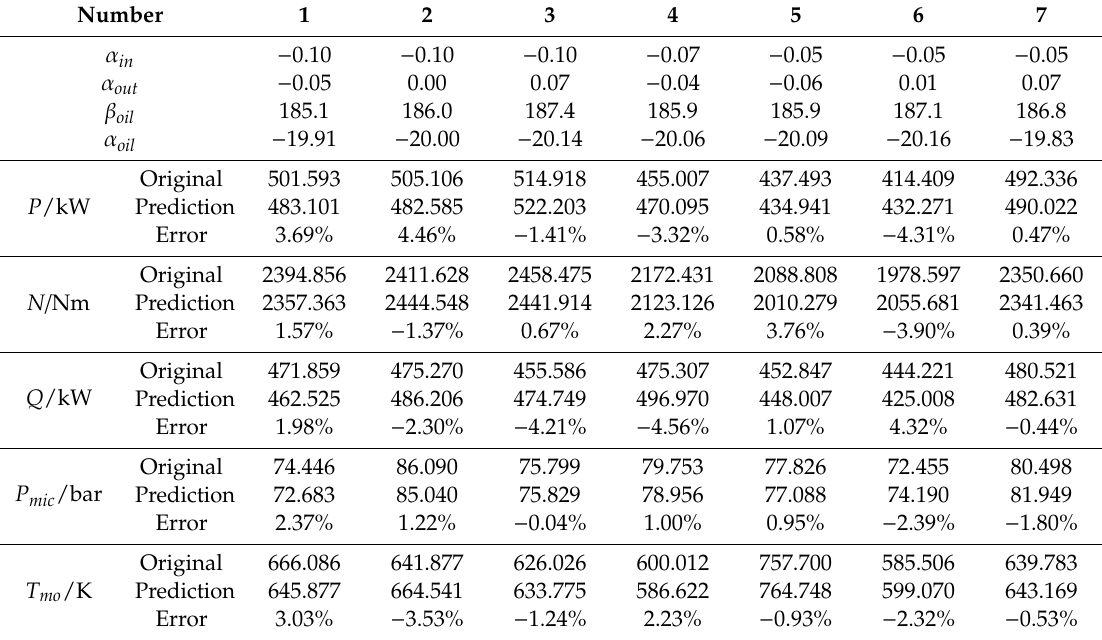
Table 8. The comparison of some original values with predicted ones in RBF-NN.